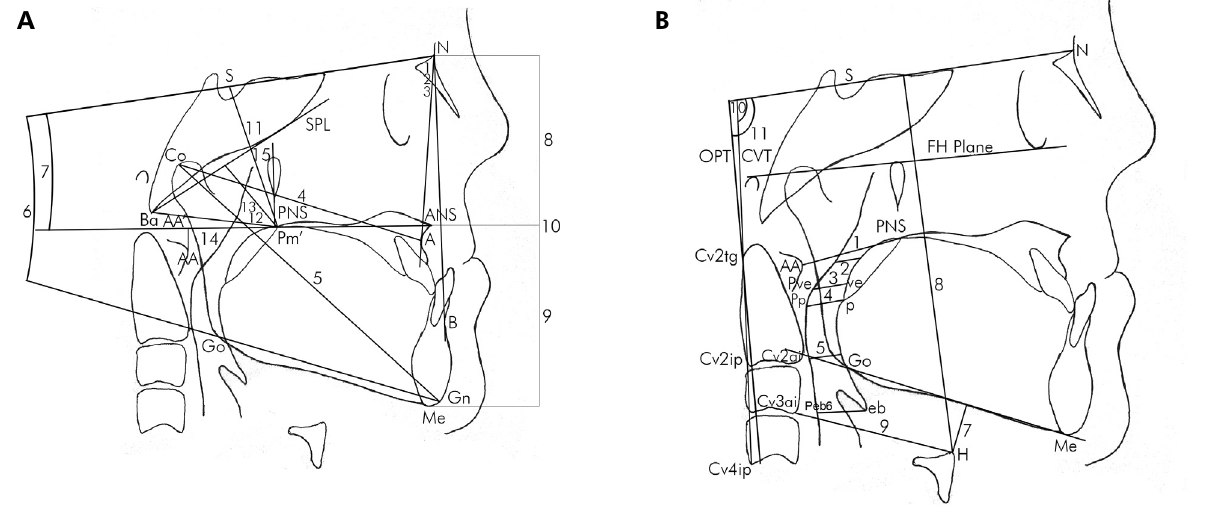
Figure 2. A: Cephalometric analysis of jaws and nasopharynx. (1) SNA; (2) SNB; (3) ANB; (4) Co-A, effective maxillary length; (5) Co-Gn, effective mandibular length; (6) SN-GoGn; (7) SN-PP, palatal plane inclination; (8) N-ANS, upper anterior facial height; (9) ANS-Me, lower anterior facial height; (10) N-Me, total anterior facial height; (11) S-PNS, nasopharyngeal height; (12) ad1-PNS, distance from PNS to lower adenoid tissue; (13) ad2-PNS, distance from PNS to upper adenoid tissue; (14) AA’-Pm’, distance between the perpendicular intersections of the anterior atlas and pterygomaxillary line along the palatal line; (15) Pm’-SPL, sphenoid line tangent to lower border of sphenoid. B: Cephalometric analysis of oropharynx, hyoid bone and head posture. (1) AA-PNS; (2) SPS, distance from the midpoint of the line from PNS to tip of soft palate to the horizontal counterpart on the posterior pharyngeal wall along parallel line to Frankfurt horizontal (FH) plane; (3) ve-Pve, distance of velum palatinum to the horizontal counterpart on the posterior pharyngeal wall along parallel line to FH plane; (4) MPS, distance from the tip of the soft palate to the horizontal counterpart on the posterior pharyngeal wall along parallel line to FH plane; (5) IPS, distance from the intersection points on the anterior and posterior pharyngeal wall through Cv2ai along parallel line to FH plane; (6) eb-Peb, distance from vallecula epiglottis to the horizontal counterpart on the posterior pharyngeal wall along parallel line to FH plane; (7) H-MP, perpendicular distance from hyoid bone to the mandibular plane; (8) H-SN, perpendicular distance from hyoid bone to SN plane; (9) C3-H, distance from the anterio-inferior point of the third cervical vertebra to point H; (10) SN-CVT, downward angle between SN plane and the line through Cv2tg and Cv4ip; (11) SN-OPT, downward angle between SN plane and the line through Cv2tg and Cv2ip.